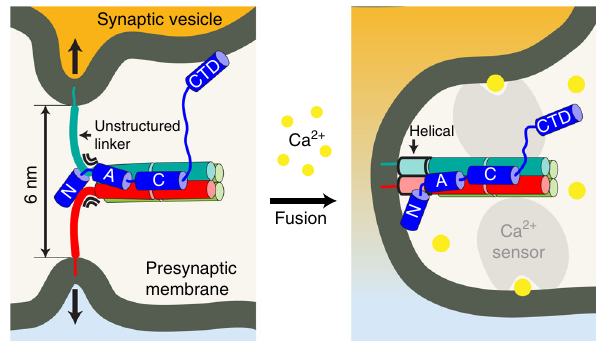
Fig. 6 A model for the function of complexin in synaptic vesicle fusion. (Left) A synaptic vesicle tethered to a presynaptic membrane via